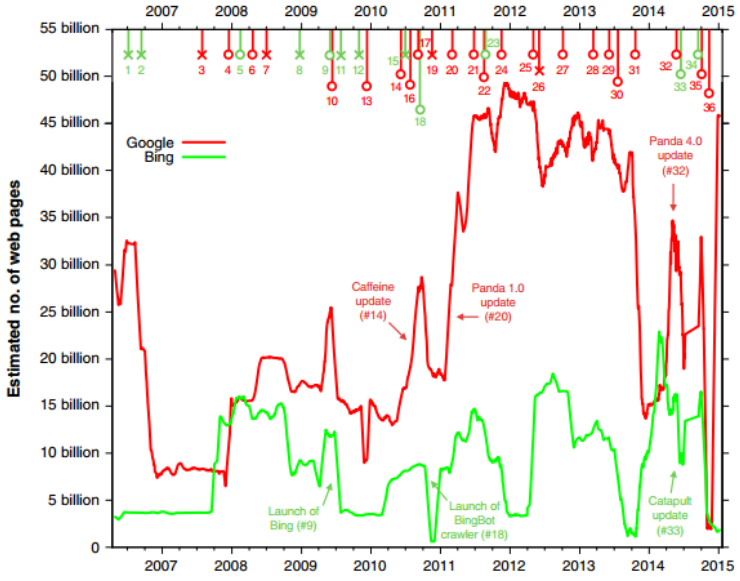
Figure 5. Estimated index sizes of Google and Bing as in